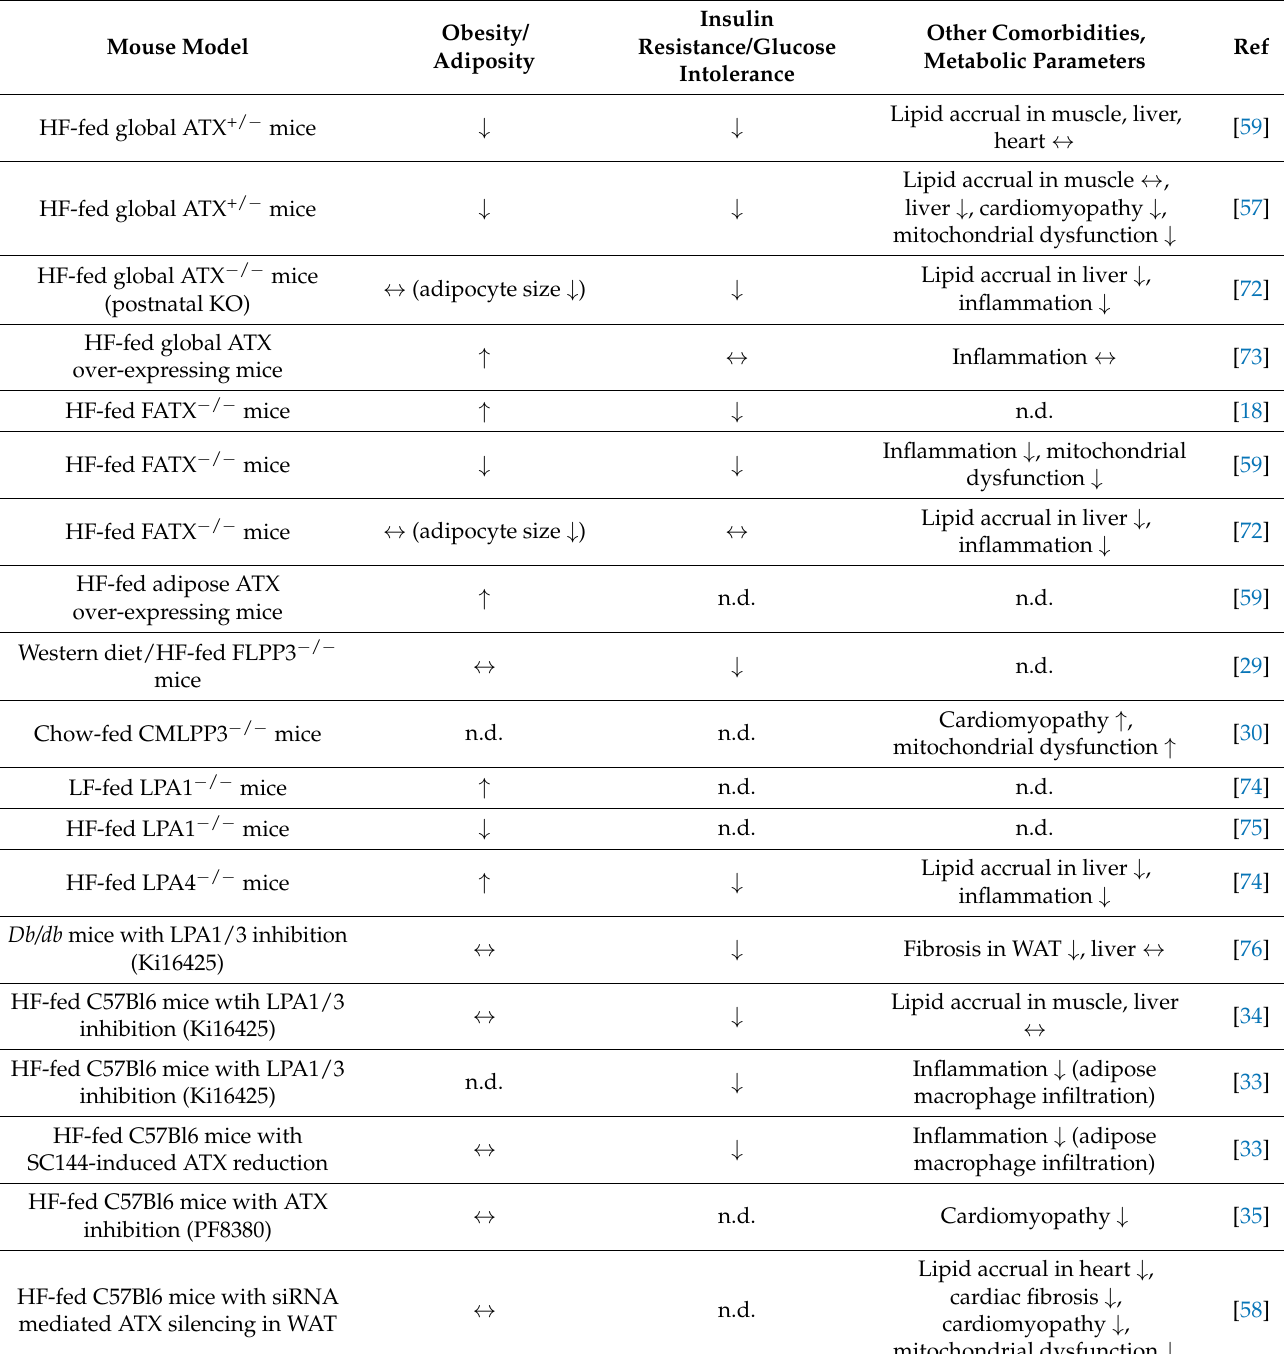
Table 1. The influence of the ATX-LPA-LPP3 signaling axis on energy metabolism and diet-induced obesity, impaired glucose homeostasis, and metabolic comorbidities based on studies involving mice with genetic or pharmacological ATX, LPA receptor, and LPP3 modulation. HF, high fat; n.d., not determined; ↑ , increased effect; ↓ , decreased effect; ↔ , no effect.